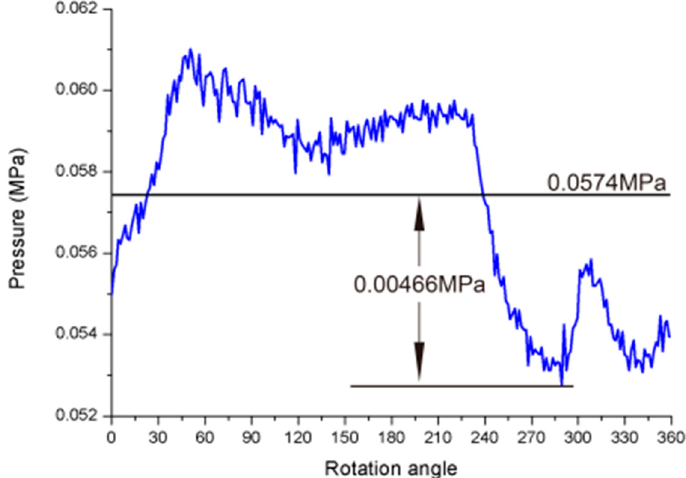
Figure 13. the pressure pulsation in suction plenum. Figure 13. The pressure pulsation in suction